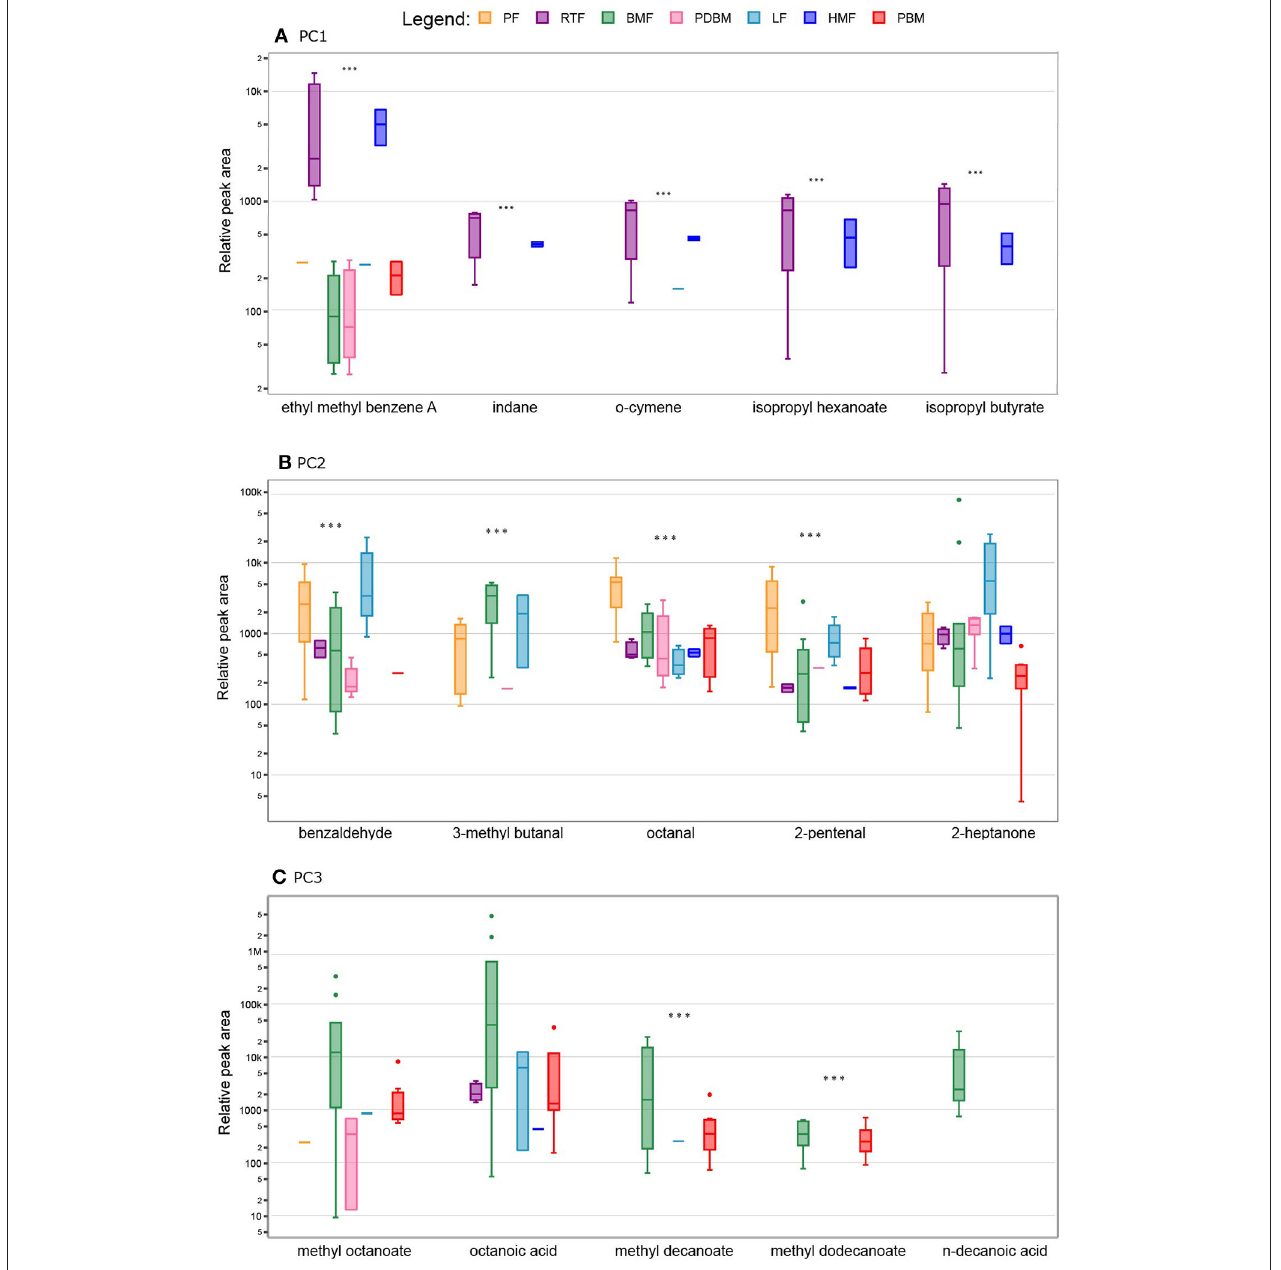
FIGURE 3 | Relative peak area of the top five volatile compounds in different milk types contributing to Principal Component (PC) Analysis. Boxes represent median and interquartile range, whiskers represent highest and lowest peak area detected and dots represent outliers. Milk types are not shown when compound was not detected. (A) Aromatic hydrocarbons and specific fatty acids contributed to differences observed in PC1; (B) aldehydes and ketones contributed to differences observed in PC2; (C) fatty acids contributed to differences observed in PC3. PF, Powder Formula; RTF, Human milk-based Ready-To-Feed formula; BMF,